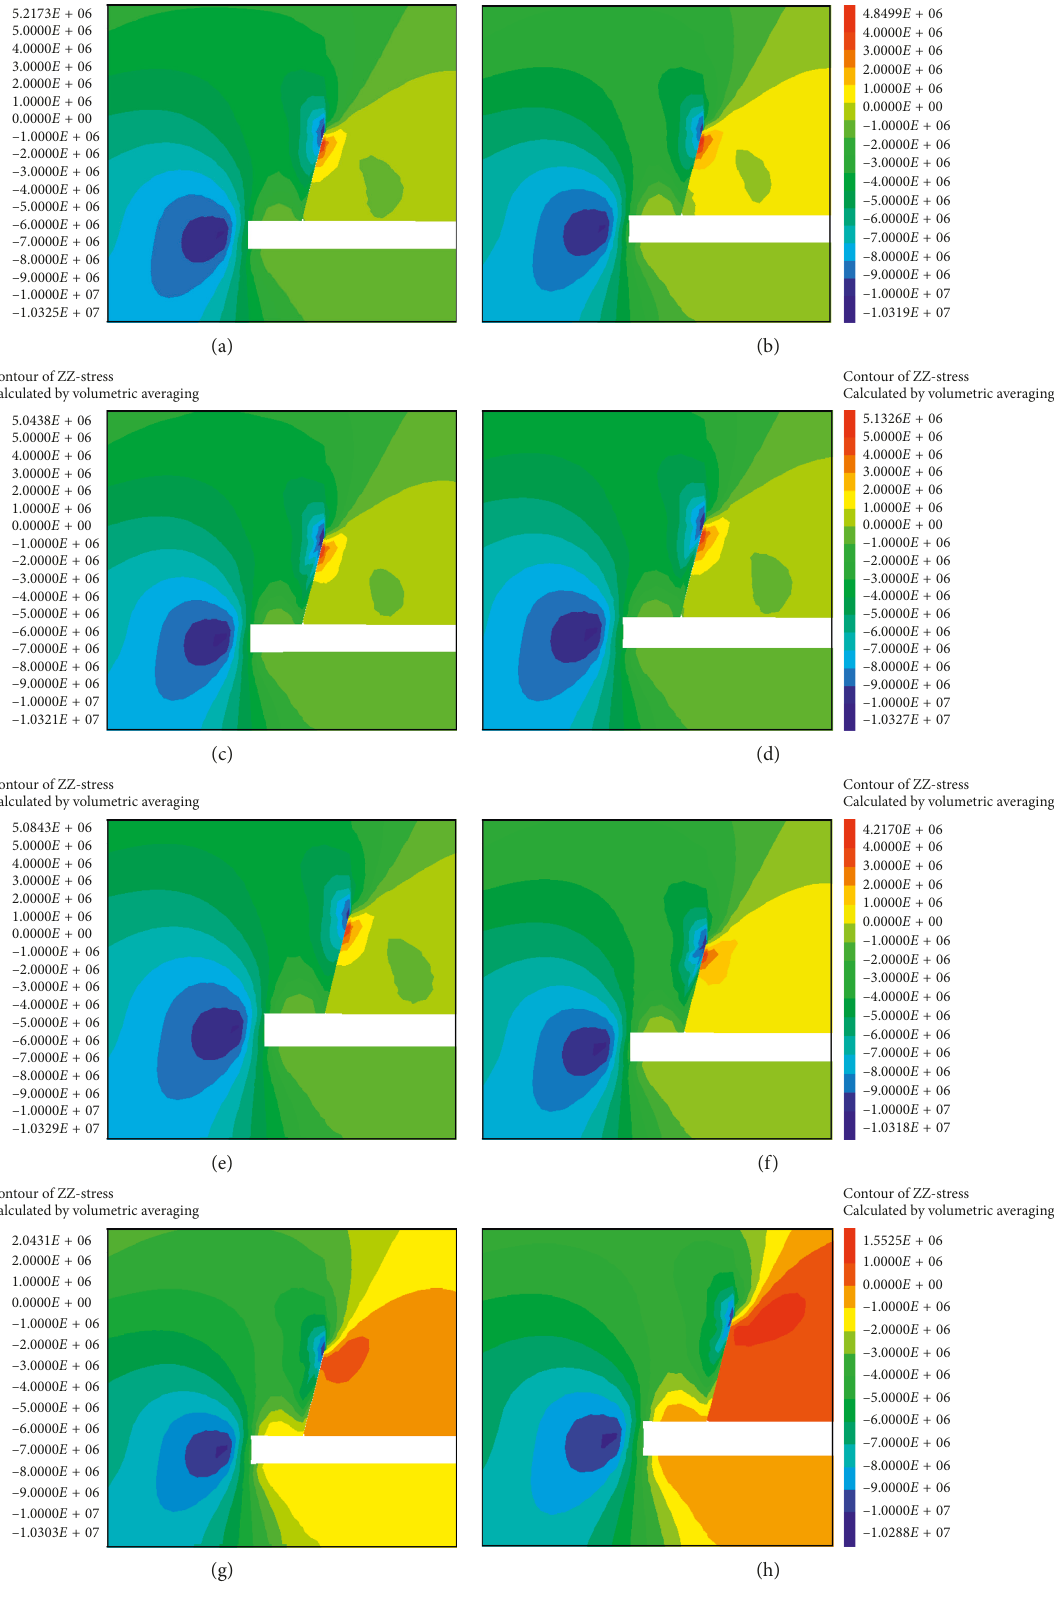
Figure 5: Numerical calculation results: mudstone layer located at (a) 0-1 m above the working face roof, (b) 1-2m above the working face roof, (c) 2-3 m above the working face roof, (d) 3-4m above the working face roof, (e) 4-5 m above the working face roof, (f) 5-6 m above the working face roof, (g) 6-7 m above the working face roof, and (h) 7-8 m above the working face